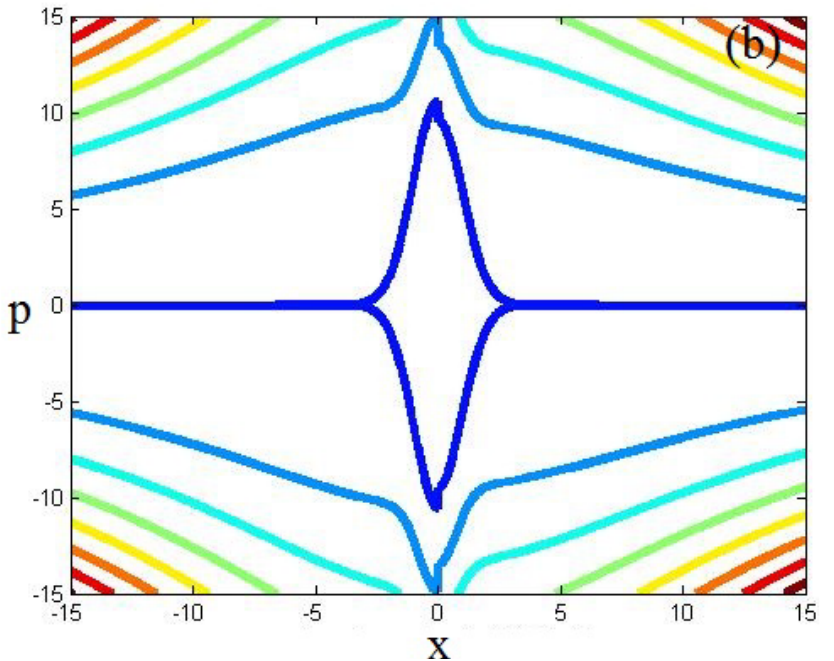
Figure 12. Phase portrait of the PDM Hamiltonian associated with Gaussian single well type potential for ( a ) λ = 0.01 and ( b ) λ = 0.1.